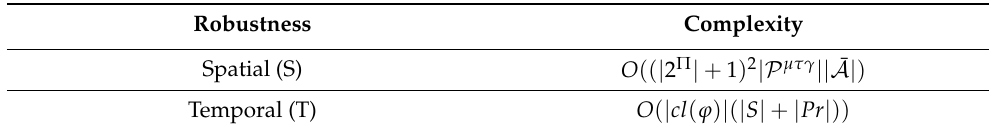
Table 1. Computational complexities of evaluating the spatial and temporal robustness when policies are given. |P µτγ | is the size of product DSG P µτγ induced by policies µ and ( τ , γ ) . | ¯ A| is the size of the timed Büchi automaton of MITL specification ¬ ϕ . | cl ( ϕ ) | denotes the size of the closure of ϕ , and | Pr | is the number of nonzero elements in matrix Pr . The complexity of Algorithm 3 is ( S ) + ( T )